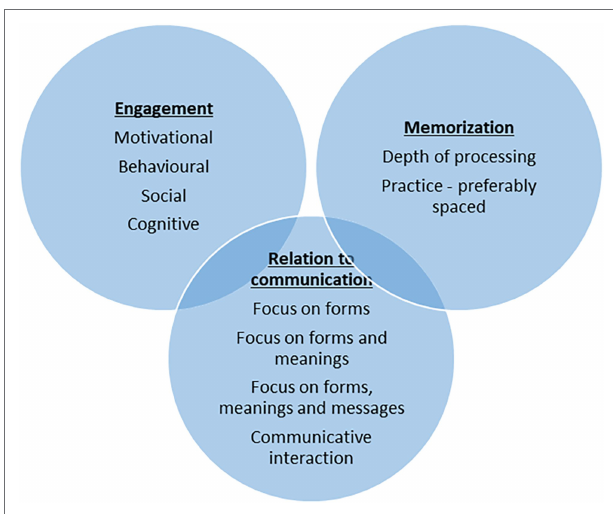
FIGURE 1 | Principles and dimensions in classroom language